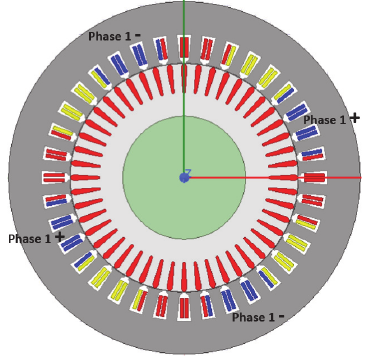
Figure A1. Geometry of the three-phase induction machine. Figure A 1. Geometry of the three ‐ phase induction machine.